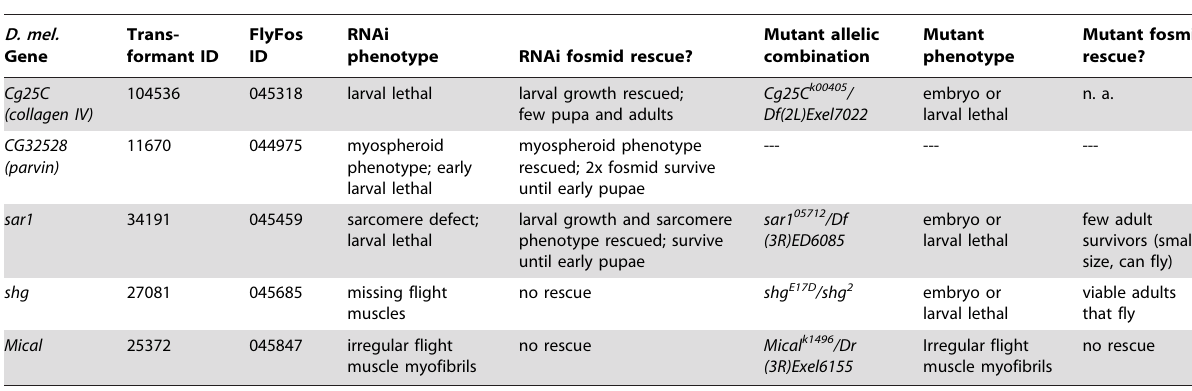
Table 1. Overview of genes and